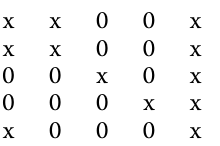
Table 4 Correlation matrix of VAR-residuals